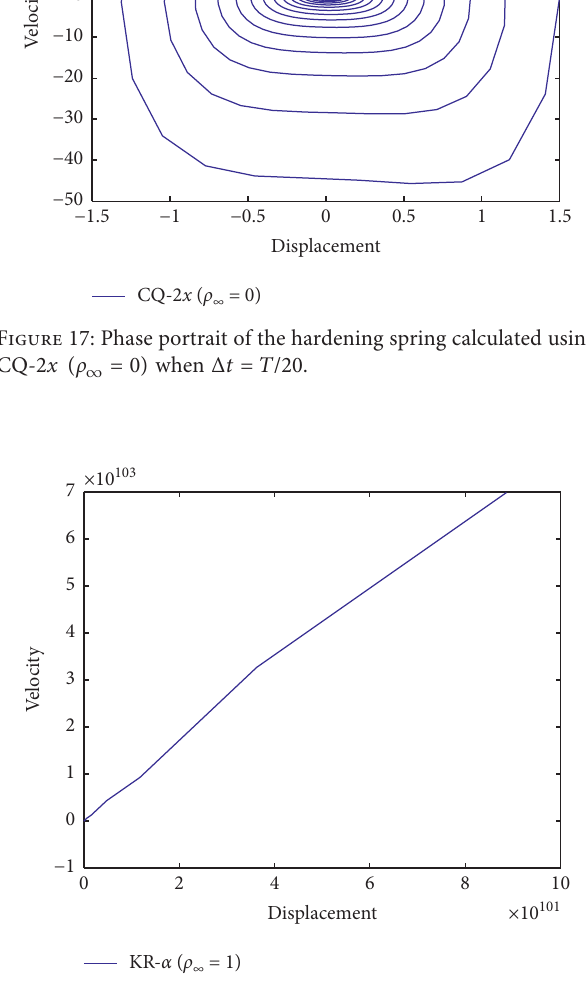
Figure 18: Phase portrait of the hardening spring calculated using � 1 ) when Δ t � T /20. the KR- α method ( ρ ∞